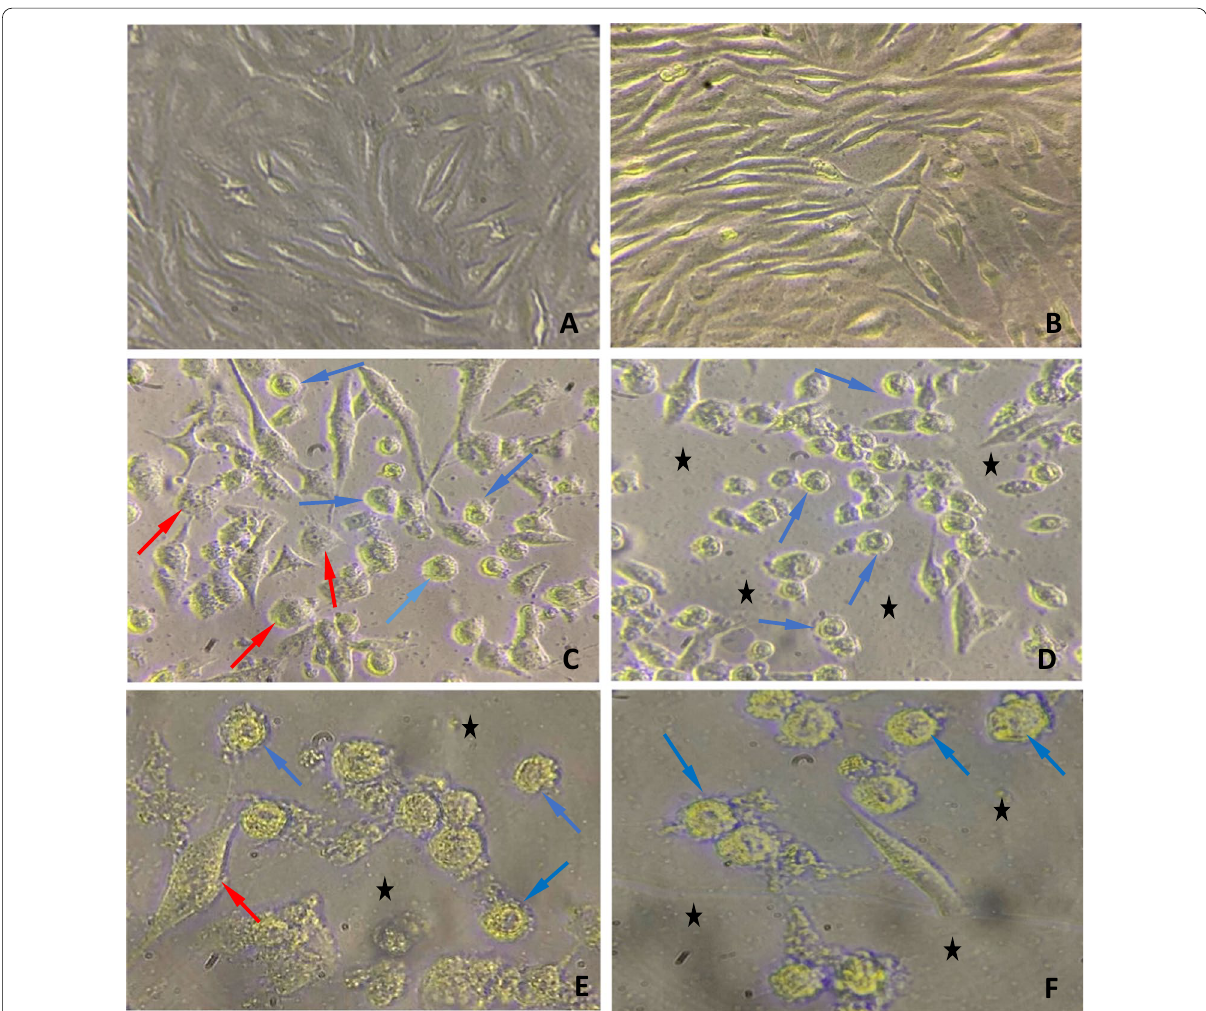
Fig. 3 Morphological analysis of SK‑GT‑4cell line following unstained. A Untreated cells after 24 h incubation, the SK‑GT‑4 show as fibroblast‑like cell, 20. B Untreated cells 72 h incubation, the SK‑GT‑4 show as fibroblast‑like cell, × to the rounded cells as dead cells, red arrows refer to shrinking cells, a rounded cell as dead cells (blue arrows), and appear more space clear from cells (star), refer to the rounded cells as dead cells, red arrows refer to swelling cells, and appear space between cells (star), after 72 h, blue arrows refer to the rounded cells as dead cells, and appear space between cells (star),